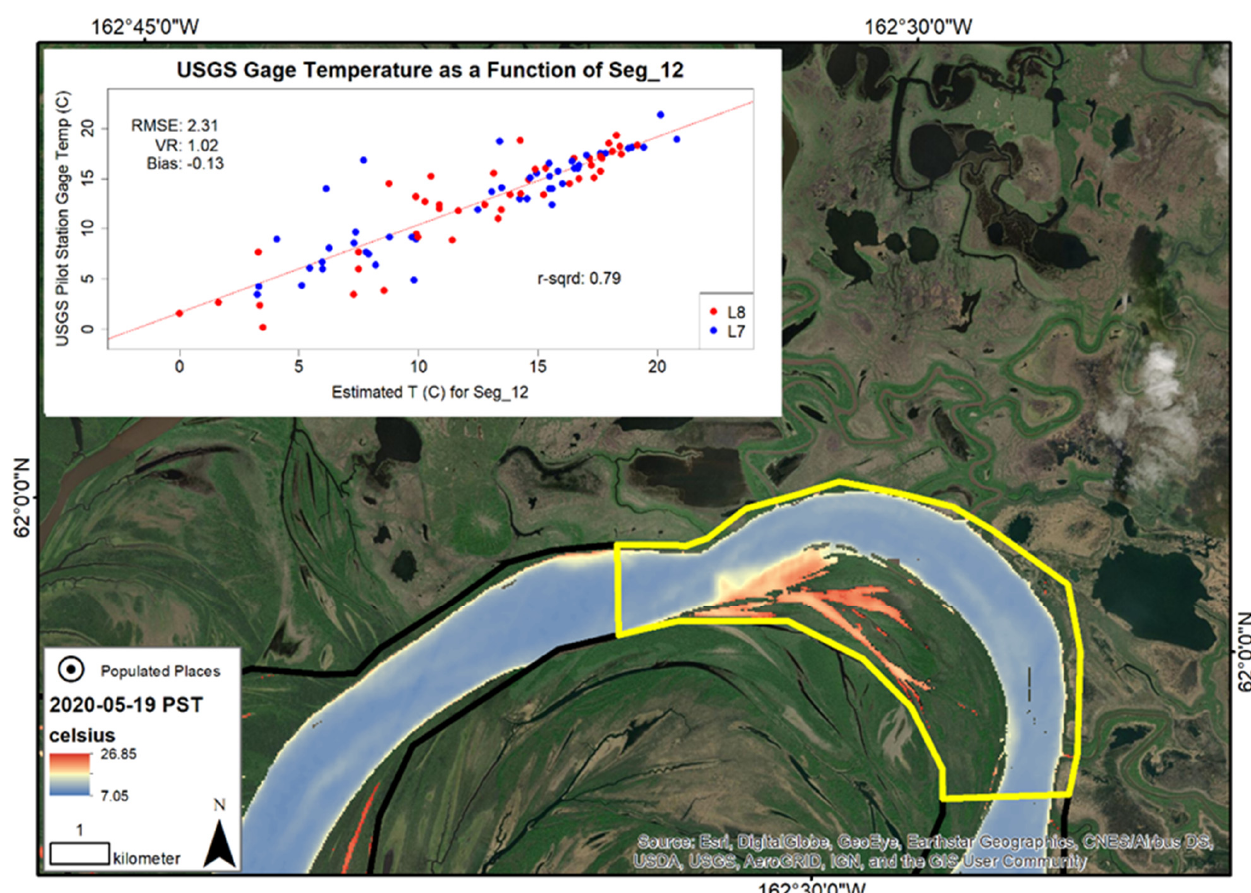
Figure A10. The Yukon River is confined to a single channel within segment 12. The channel occupies a large meander with low-lying wetlands to the north and an accreting point bar to the south that is also covered in wetlands. The accreting edge of the point bar is exposed as a sand and gravel bar when the river is not at high stages. At high stages, the sand/gravel bar is inundated as depicted in the scene above. A swath of backwater extends across the point bar at times as captured in the above scene. The backwaters appear as warmer inland water. Correlation between water temperature and the concurrently measured water temperature at Pilot Station is good (RMSE = 2.31 °C, r 2 = 0.795).